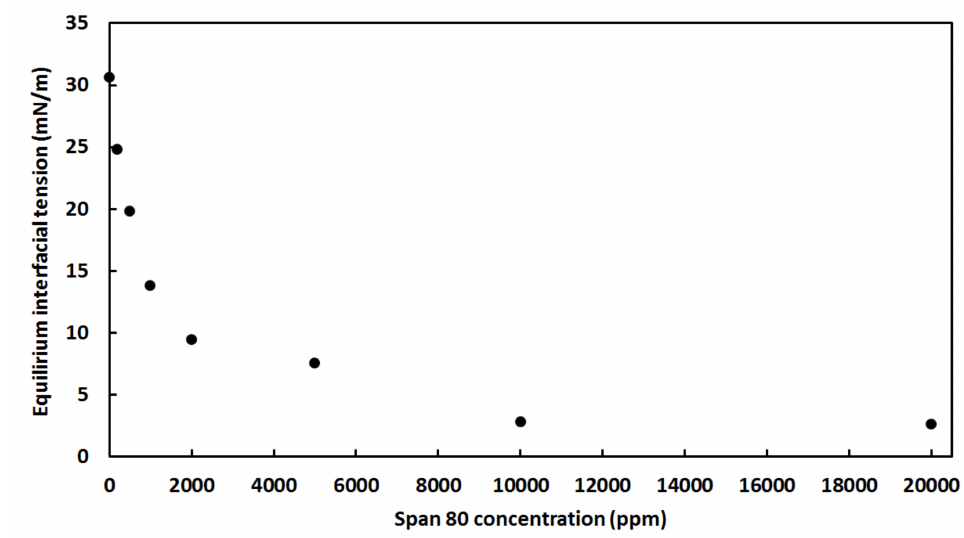
Figure 3. Equilibrium crude oil-water interfacial tensions at various Span 80